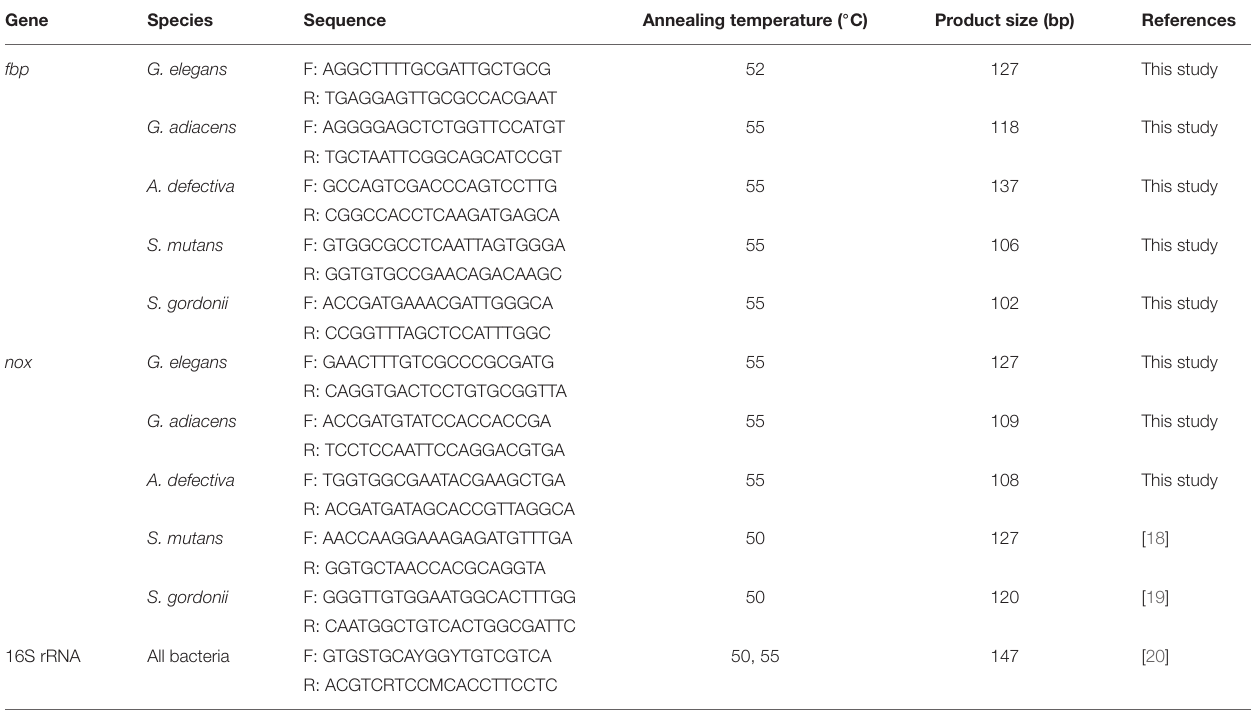
TABLE 1 | Primers used in this